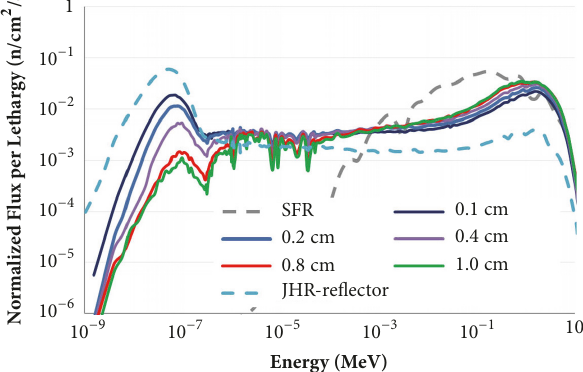
Figure 8: Effect of different thicknesses of booster (0.1, 0.2, 0.4, 0.8, and1.0cm)ontheneutronspectrum.SFRandJHRreflectorneutron spectra are also depicted.